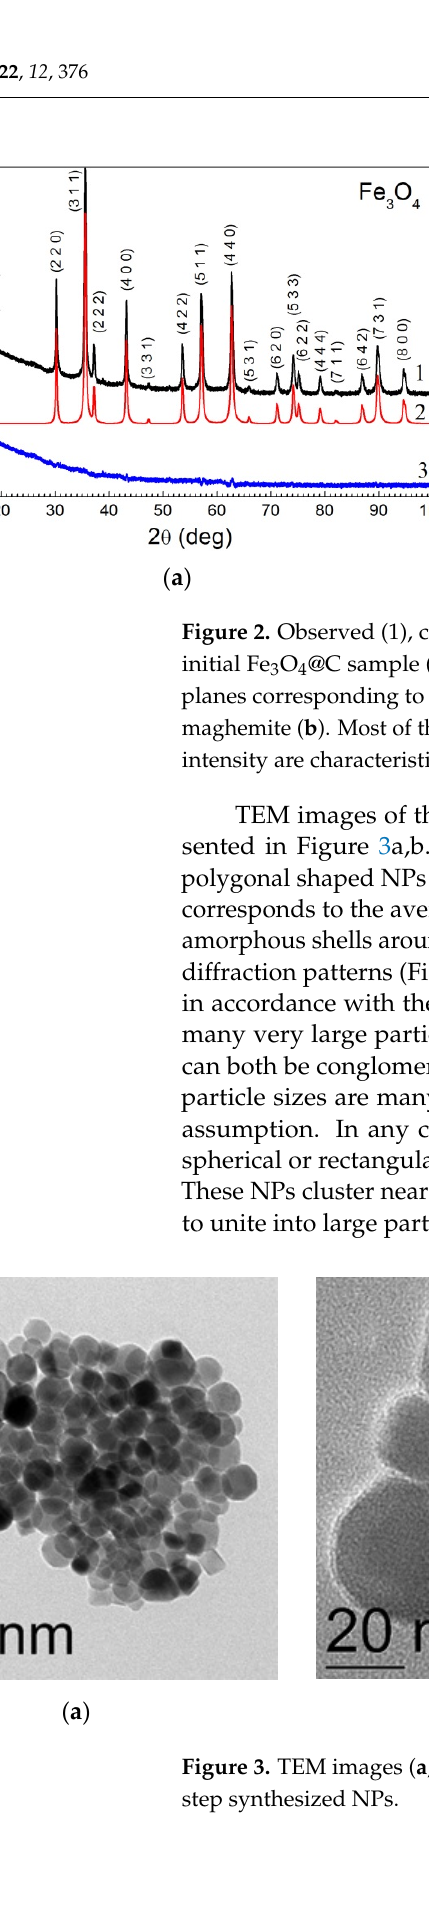
Figure 4. TEM images of the two steps synthesized Fe 3 O 4 @C@C NPs with different magnification. To remove excess organic solvent and by-products from the surface of NPs, we car- ried out thermal treatment of the NPs powder in the course of thermo-gravimetric anal- ysis (TG) combined with differential scanning calorimetry (DSC) when the sample was heated up to 600 °C in the argon atmosphere. As seen in Figure 5, the process of thermal destruction took place in, at least, two stages. The first stage (temperature region 200–300 °C) was probably associated with the destruction of the outer carbon layer, leading to a small decrease of 1.6% of the original mass (TG curve) and to a change in specific heat (DSC curve) due to the partial carbon withdrawal. The second stage (300–500 °C) of the process proceeds more intensive- ly—the weight loss is 7.6%, and the weight loss rate is 0.7%/min, and is accompanied by an endothermic effect with a maximum at 466 °C, with a change in enthalpy of 34.5 J/g.